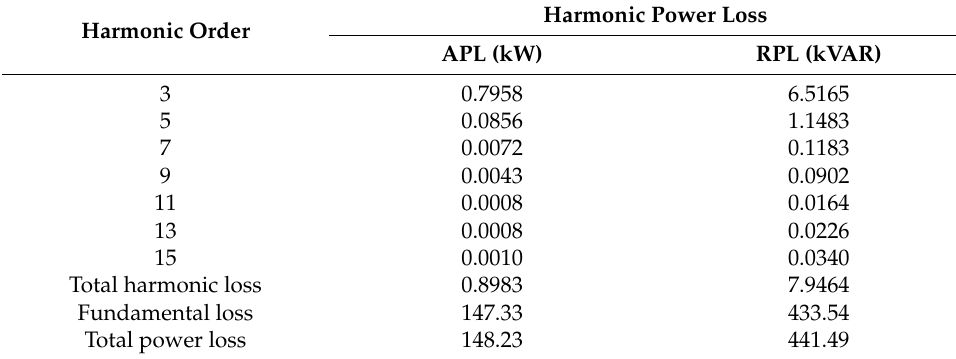
Table 6. Power loss in IEEE − 13 bus